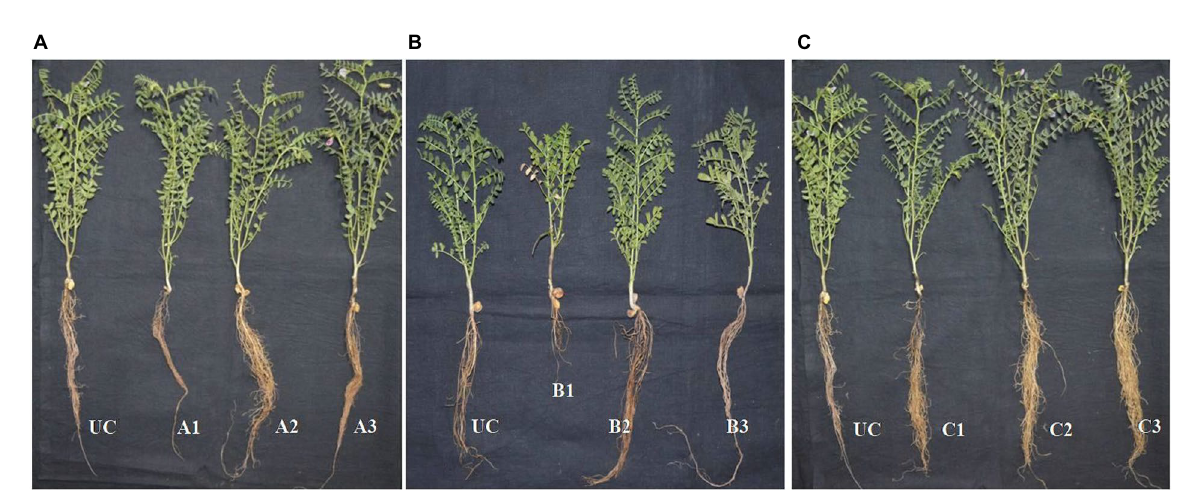
FIGURE 3 Effect of bacterial endophytes on suppression of root wilt complex disease in chickpea plants ( A , R. solani pre-challenged; B , S. rolfsii pre- challenged; C , F. oxysporum f. sp. ciceri pre-challenged). Treatment details: UC-Uninoculated (negative control which is not inoculated with a pathogen or bacterial strain). A1, B1, C1 – Positive control of R. solani , S. rolfsii, and F. oxysporum f. sp. ciceri , respectively in which only pathogen inoculated. A2, B2, C2 – Respective pathogen + B. subtilis strain TRO4 inoculated. A3, B3, C3 – Respective pathogen + B. subtilis strain CLO5 inoculated. The age of the plant under observation was 45 days after